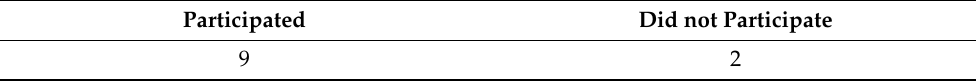
Table 2. Participation in HRC activities by residents (excluding committee members).